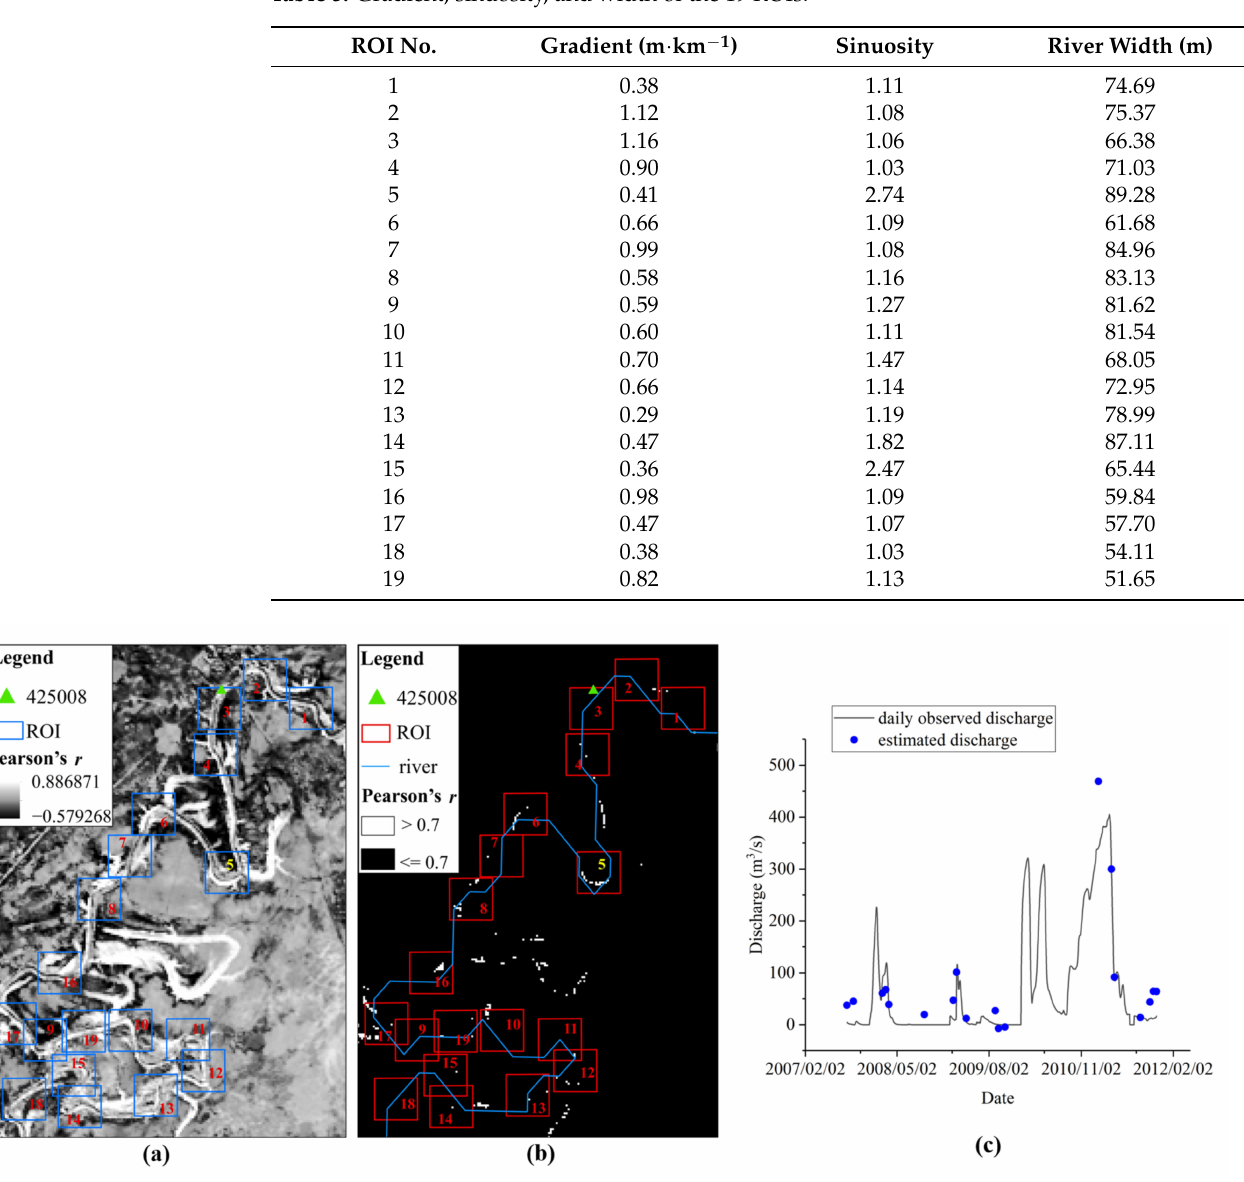
Figure 9. ( a ) The selected 19 ROIs and the calculated Pearson’s r image within the whole study site. ( b ) Pearson’s r larger than 0.7. ( c ) Estimated discharge using the optimized ROI (ROI 5) and observed discharge for Gauge